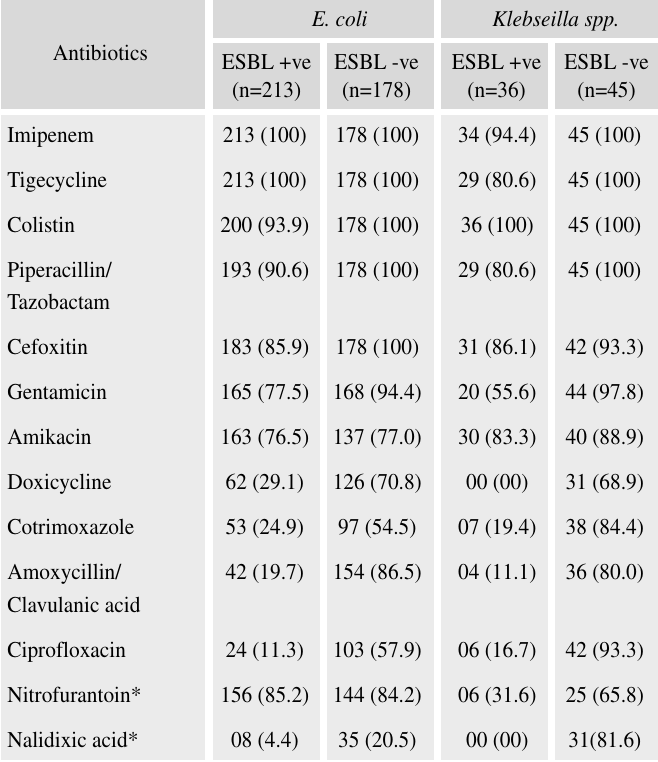
Table III: Sensitivity pattern of ESBL positive and ESBL negative E. coli and Klebsiella spp. to different antibiotics (except cephalosporins)